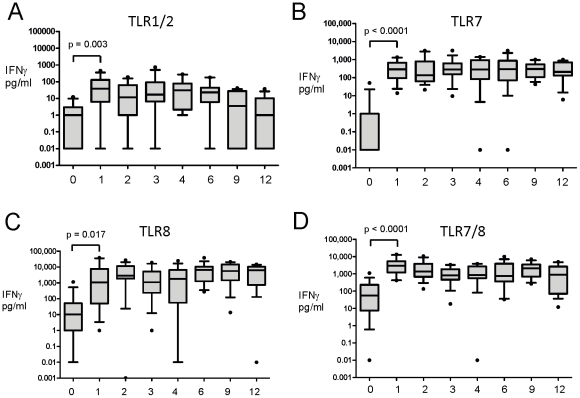
Net TLR-mediated IFNγ responses differ between agonists and
across the first year of life.100 µl of whole blood was cultured overnight with (A) Pam3CSK4
(TLR1/2 agonist), (B) Gardiquimod™ (TLR7 agonist), (C) ssRNA (TLR8
agonist) and (D) CL075 (TLR7/8 agonist) at birth (cord), 1, 2, 3, 4, 6,
9 and 12 months of age (x axis) and IFNγ cytokine production (y
axis) was measured in supernatants (pg/mL) as described in Materials and Methods. Unstimulated
values are subtracted from stimulated values and data were presented as
box and whisker, n = 12–15.